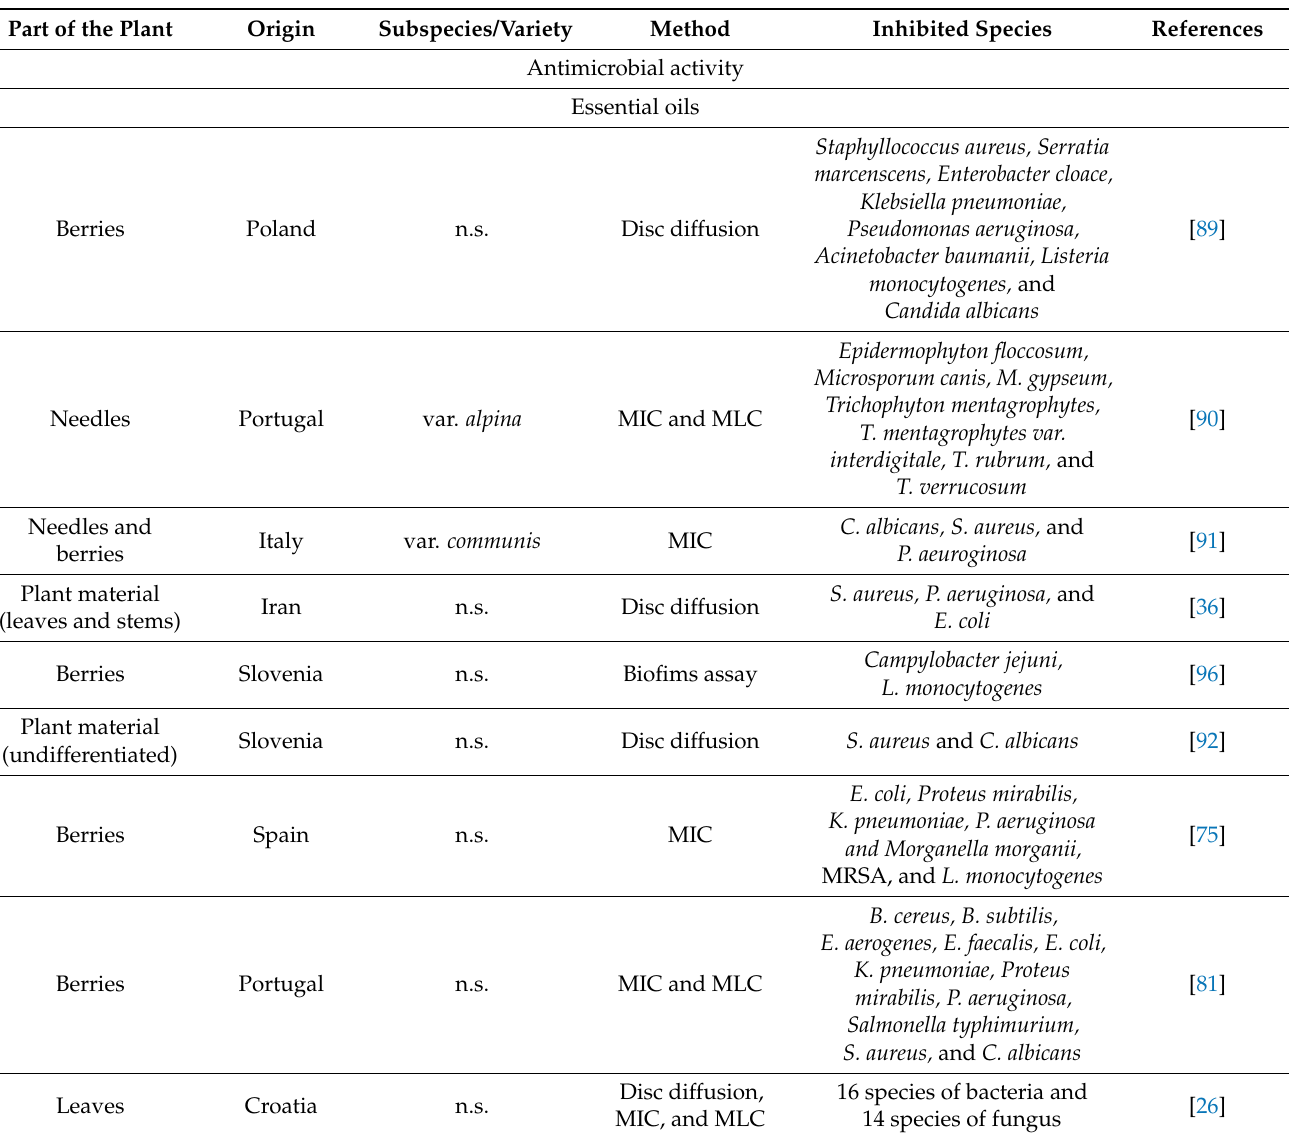
Table 2. Antimicrobial and antiparasitic activity of different Juniperus communis